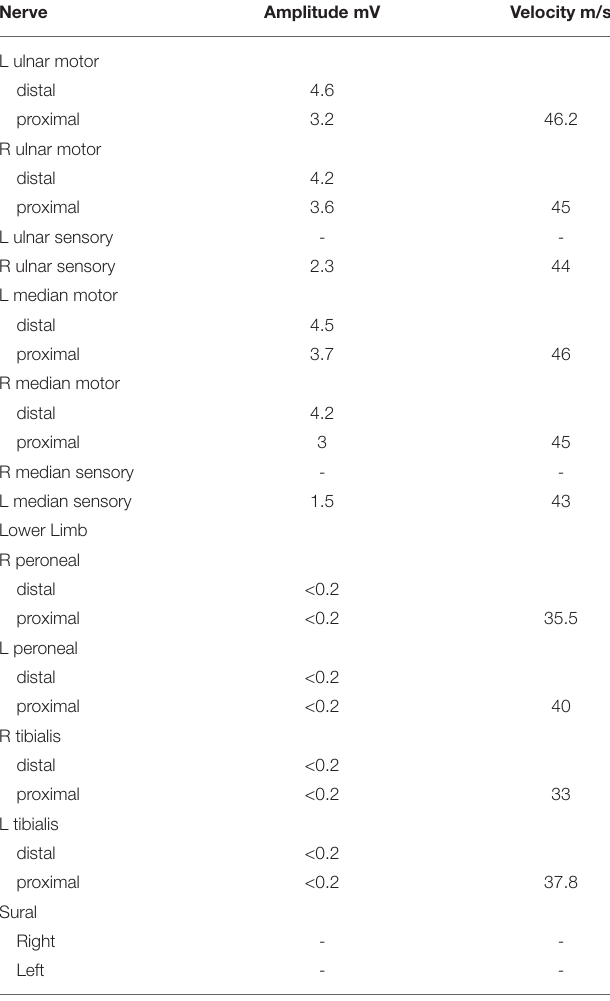
TABLE 1 | Neurophysiological study of patient.